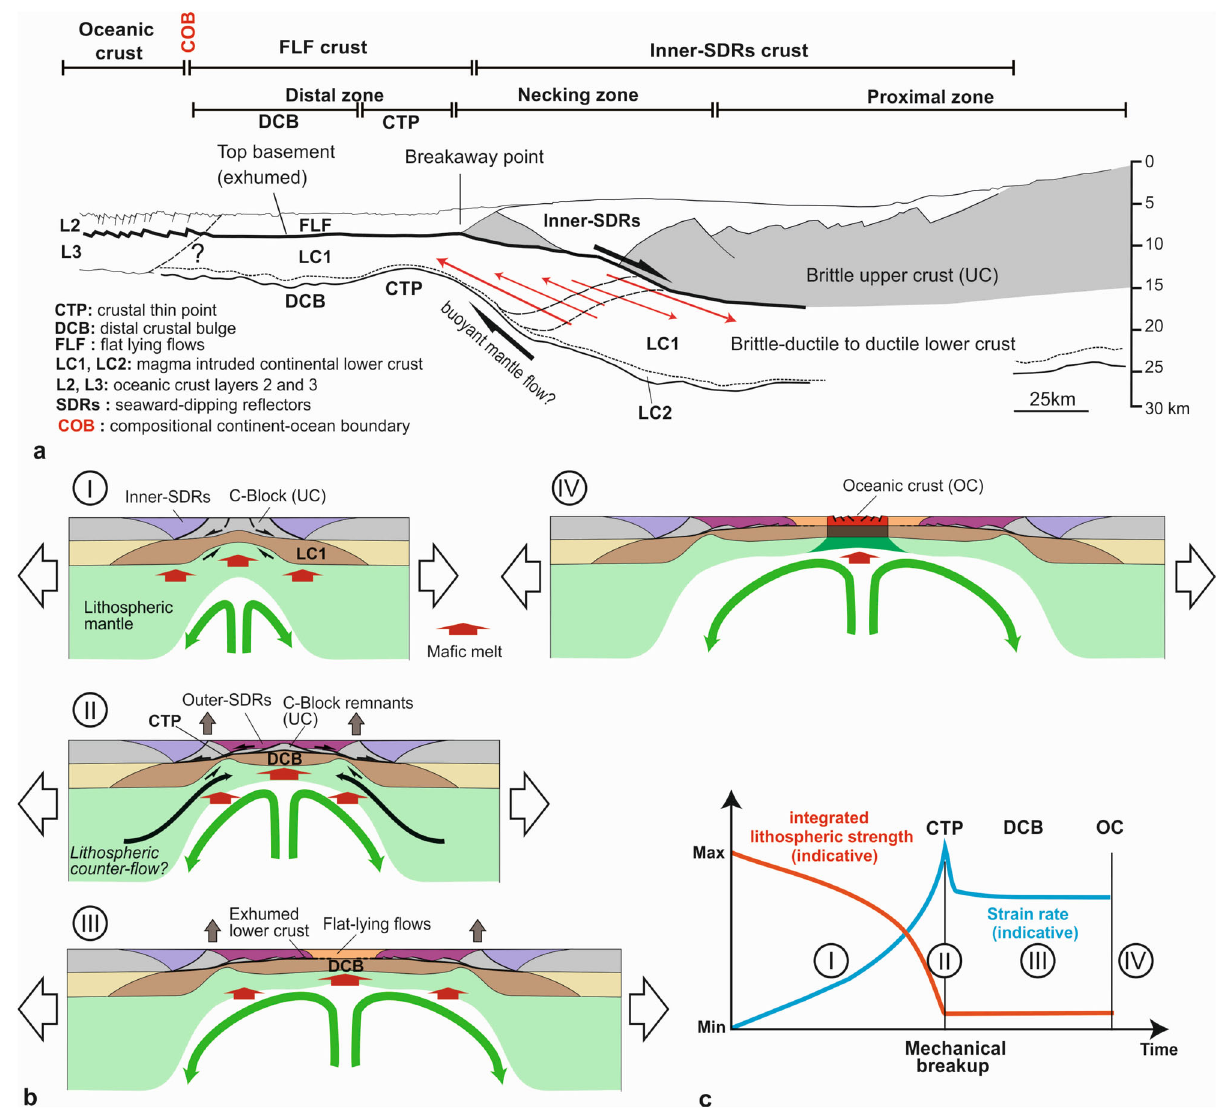
Fig. 6 Tectonic interpretation and breakup model. a Tectonic interpretation at crustal scale (drawn from ION TM line VI, Figs. 2, 3a); b suggested lithosphere evolution during breakup: crust necking (1), breaking up (2), and steady-state expanding in pure shear (3); c suggested strain rate and lithosphere integrated strength evolution with time. Numbers refer to ( b